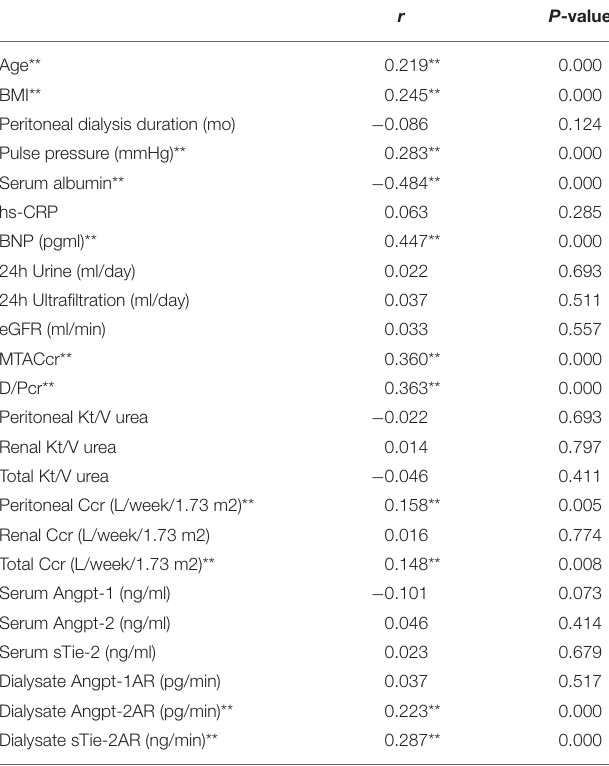
TABLE 3 | Multivariate associations between peritoneal protein clearance and patient characteristics.